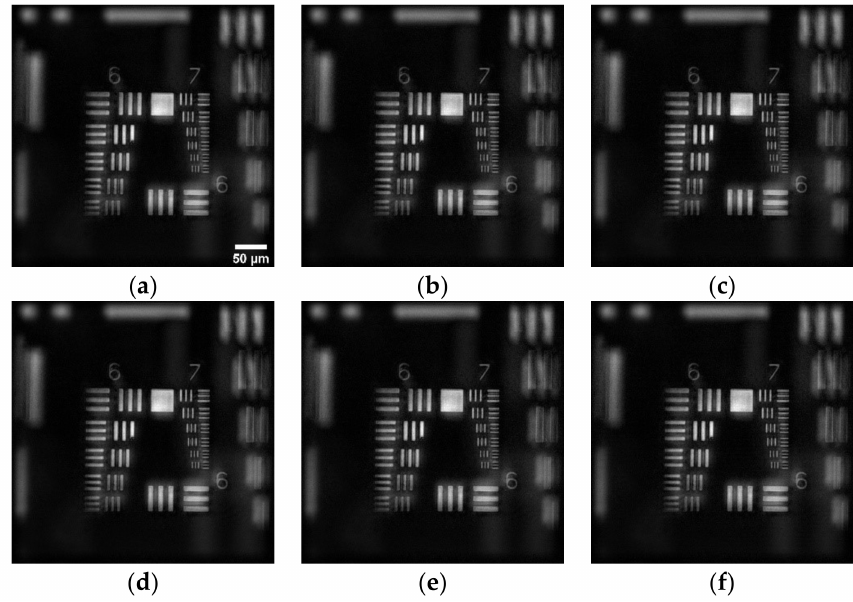
Figure 5. Reconstructed images using ( a – c ) the conventional technique and ( d – f ) the proposed technique using the interpolation algorithms ( a , d ) bilinear, ( b , e ) bicubic, and ( c , f ) Lanczos-3.